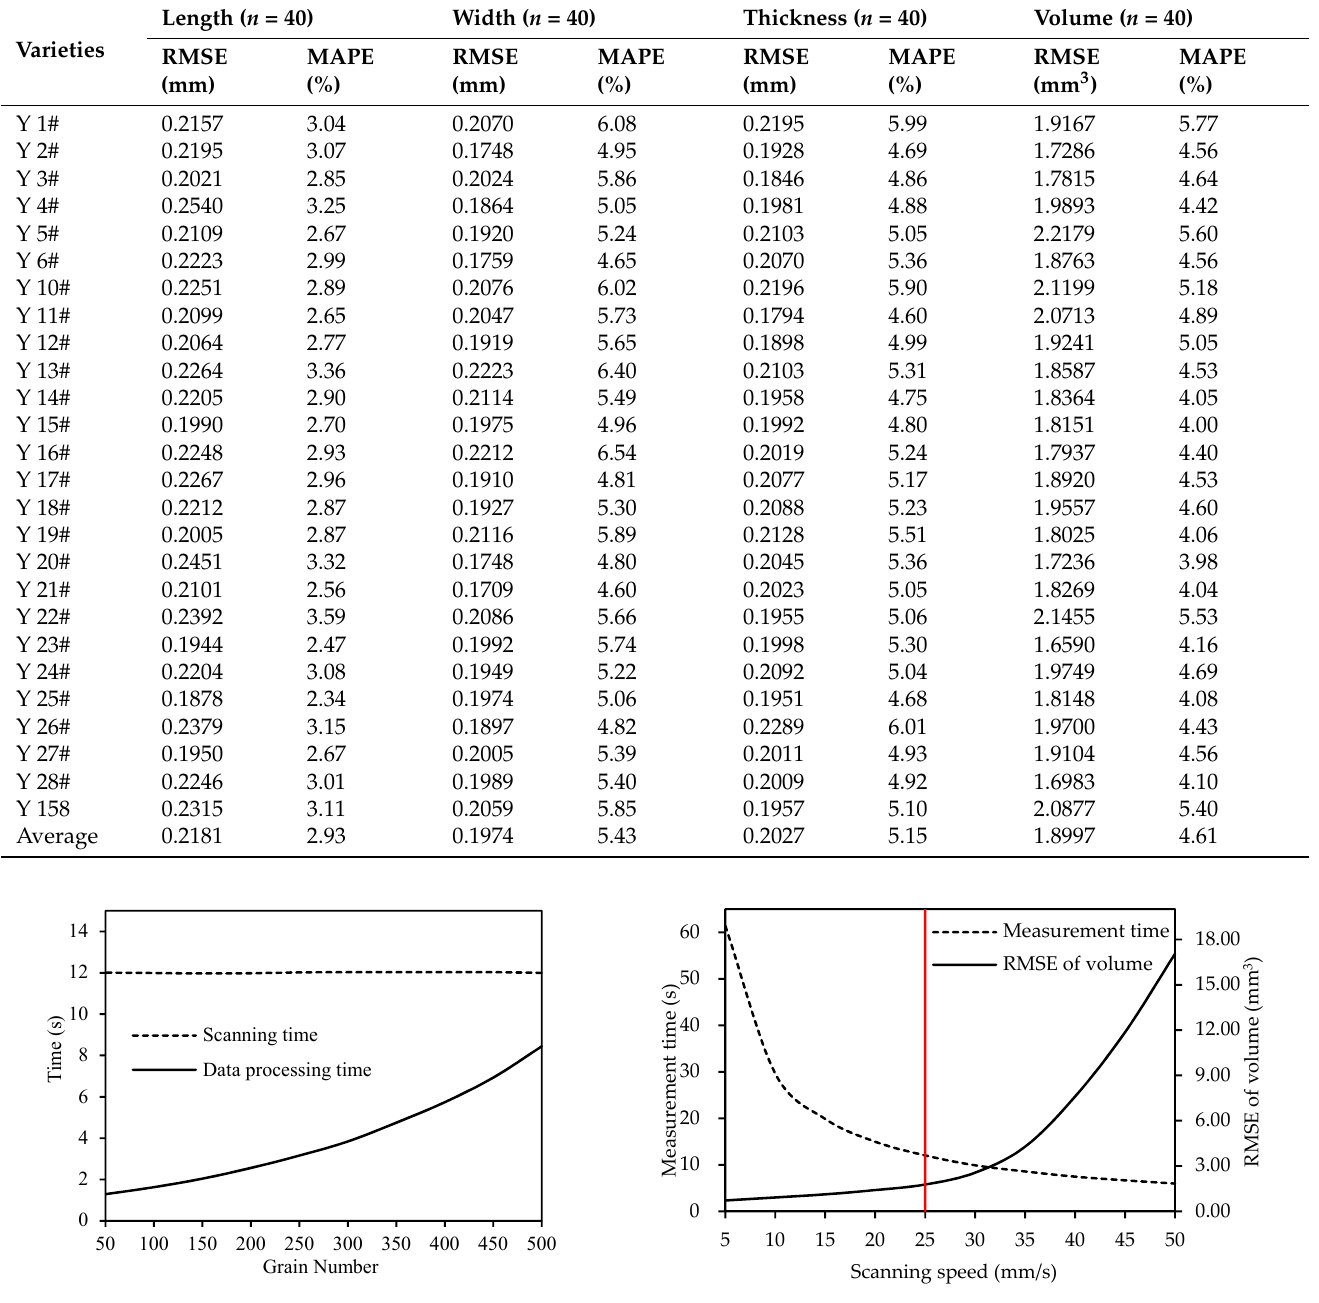
Table 3. Measurement accuracy of Yangmai series varieties.